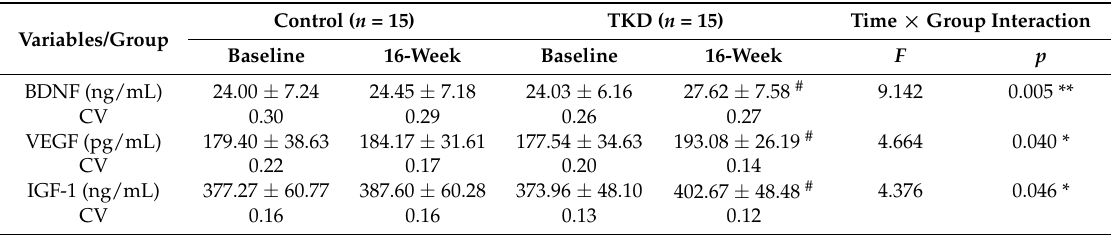
Table 4. The levels of serum neuroplasticity-related growth factors in the control and TKD groups before and after the